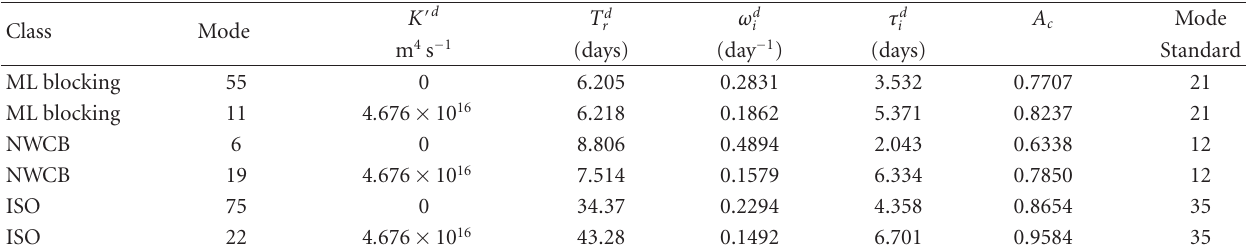
Table 4: As in Table 3 for modes for 1975–94 basic states with di ff erent dissipation parameterizations, K (cid:3) d , that have the largest pattern correlations, A c , with leading ML blocking, NWCB, and ISO modes for the 1975–94 basic state with standard parameterizations.